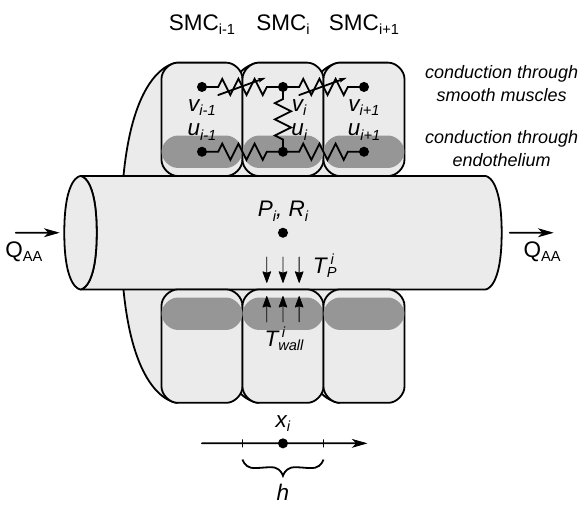
Figure 2. A segment of the model afferent arteriole. The vascular wall consists of a chain of smooth muscle cells (SMC). The local vascular radius R i is determined by the balance of T i depend on local blood pressure P i and the contractile state of the surrounding myocyte, respectively. Along the vascular wall, signals are conducted directly through the smooth muscles ( v i − 1 ↔ v i ↔ v i + 1 ) or indirectly through the endothelium (shaded region, u i − 1 ↔ u i ↔ u i + 1 ). For simplicity, we only show selected intercellular currents. See Section 2.1.2 for complete equations.